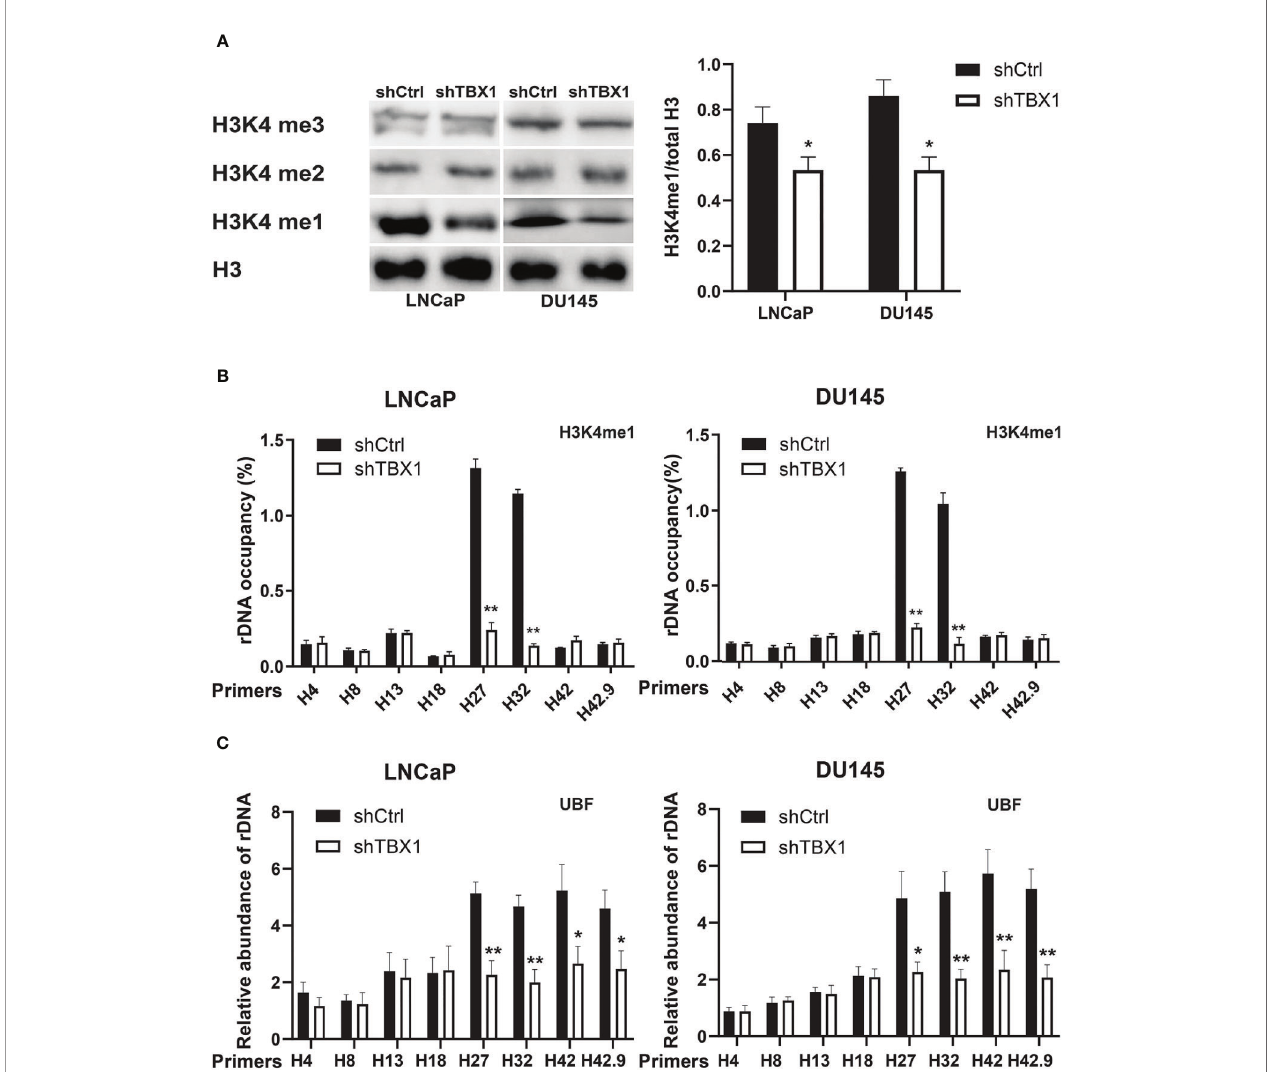
FIGURE 6 | TBX1 silencing inhibits H3K4me1 and UBF binding with rRNA genes. (A) Left, Western blot analysis results of H3K4me1 expression. Right, quantitative results of the left panel. (B) CHIP – qPCR analysis results of the level of H3K4me1 binding with rRNA genes. (C) CHIP – qPCR analysis results of the level of UBF binding with rRNA genes. The data represent the mean ± SD of three independent experiments. ** p < 0.01; * p < 0.05, shTBX1 vs. shCtrl. Upstream binding factor,